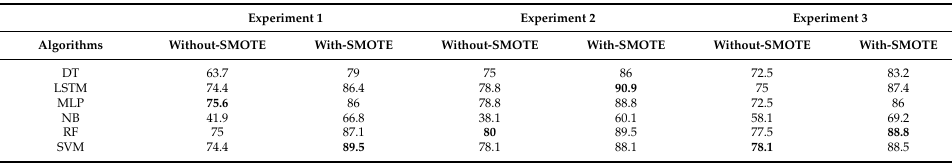
Table 8. Experiments Comparison